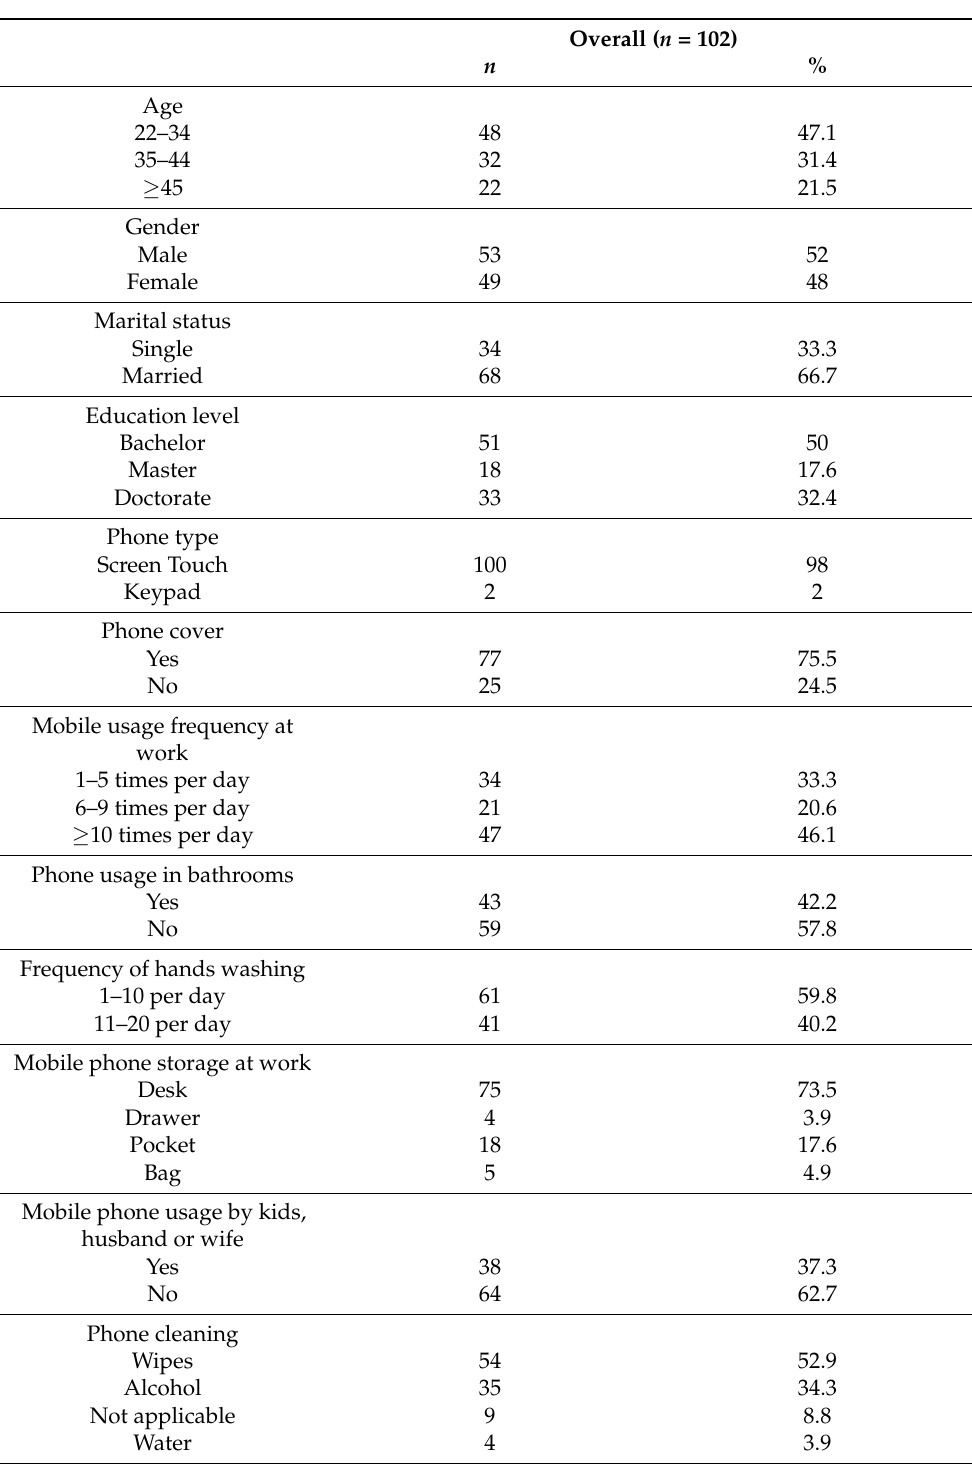
Table 1. Participants sociodemographic characteristics and mobile hygiene